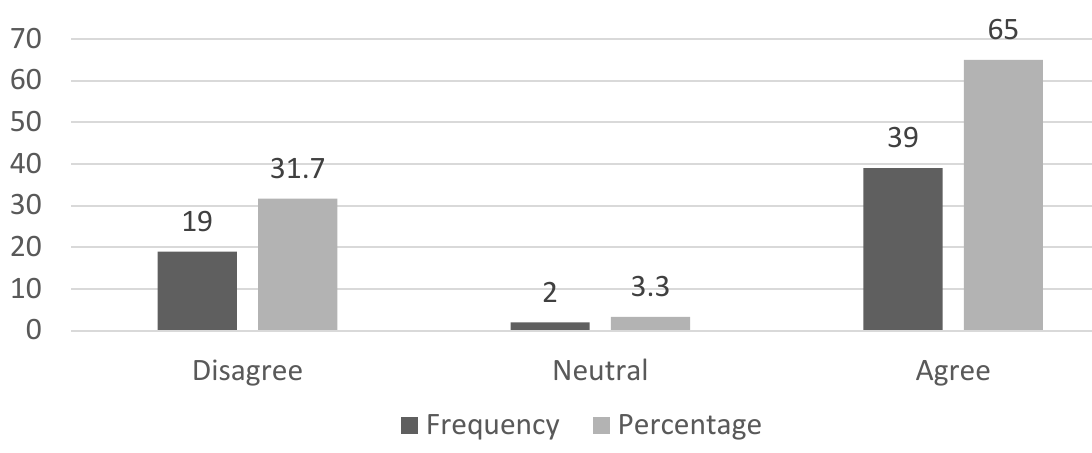
Figure 4. Level of cooperation and Figure 4 revealed insufficient collaboration be- tween MFIs and regulatory authorities in Ghana.